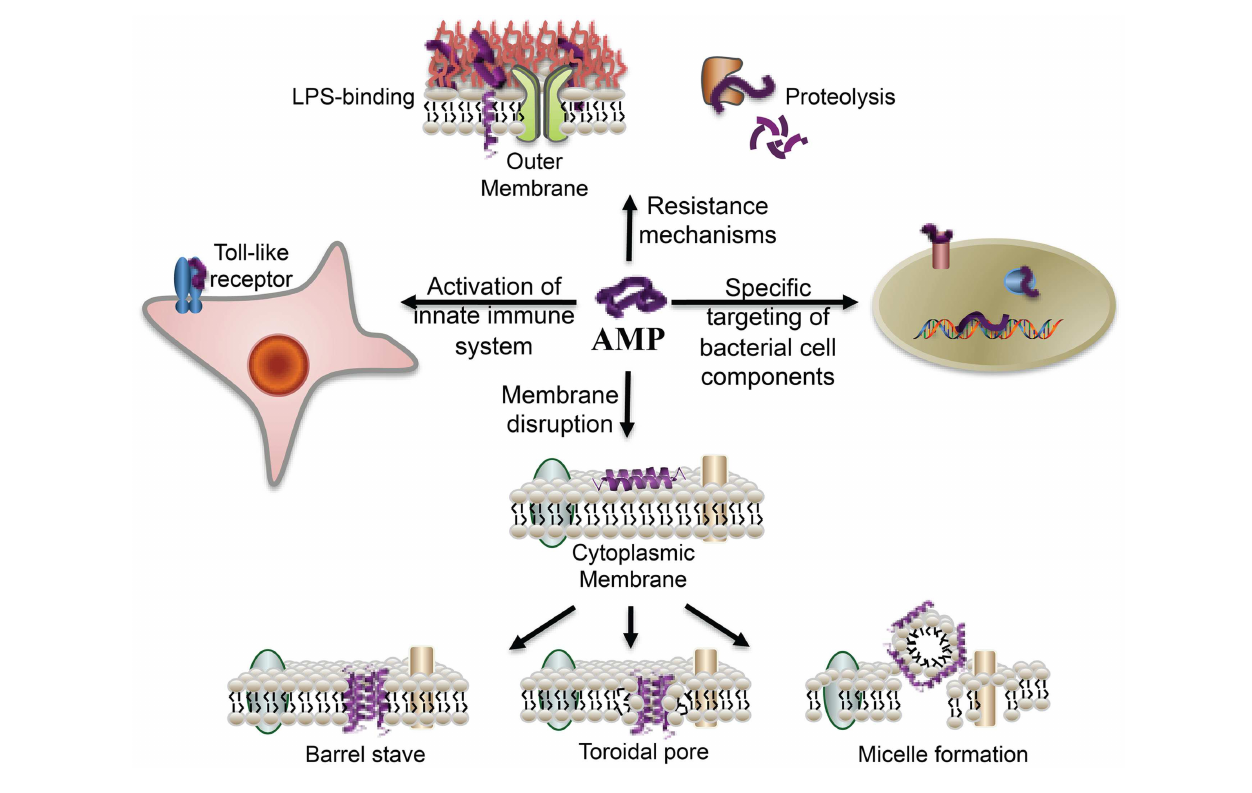
innate immune system.The binding of peptides to cell-surface LPS molecules and proteolysis contribute to bacterial resistance to AMPs (From Marsh et al., 2009, reproduced by permission of the Royal Society of